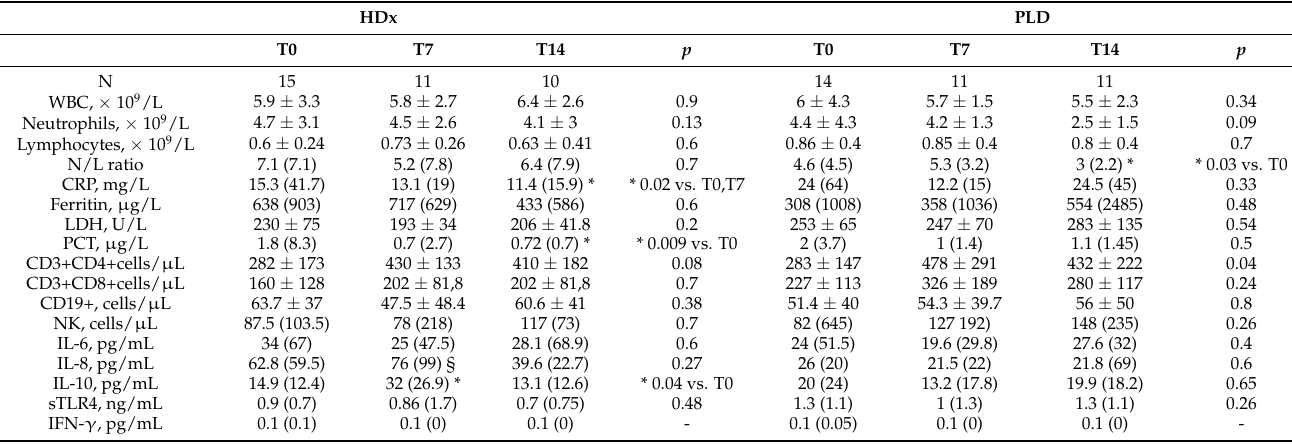
Table 3. Longitudinal changes of biochemical parameters and inflammatory cytokines in COVID-19 patients treated with two different dialysis membranes.